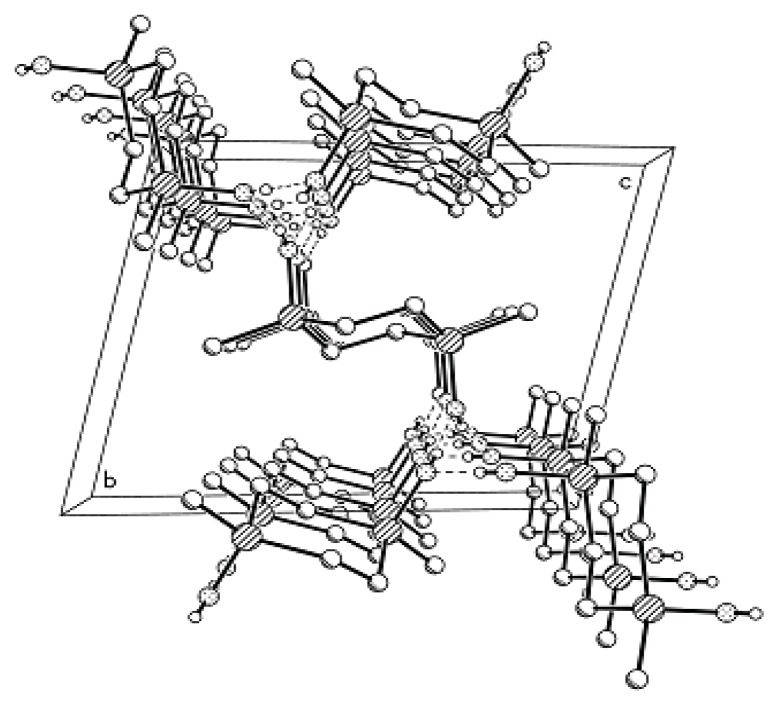
Molecular packing in the crystal of Compound MXI-OH. Dashed lines denote intermolecular H-bonds that link molecules to form columns along the x-axis.